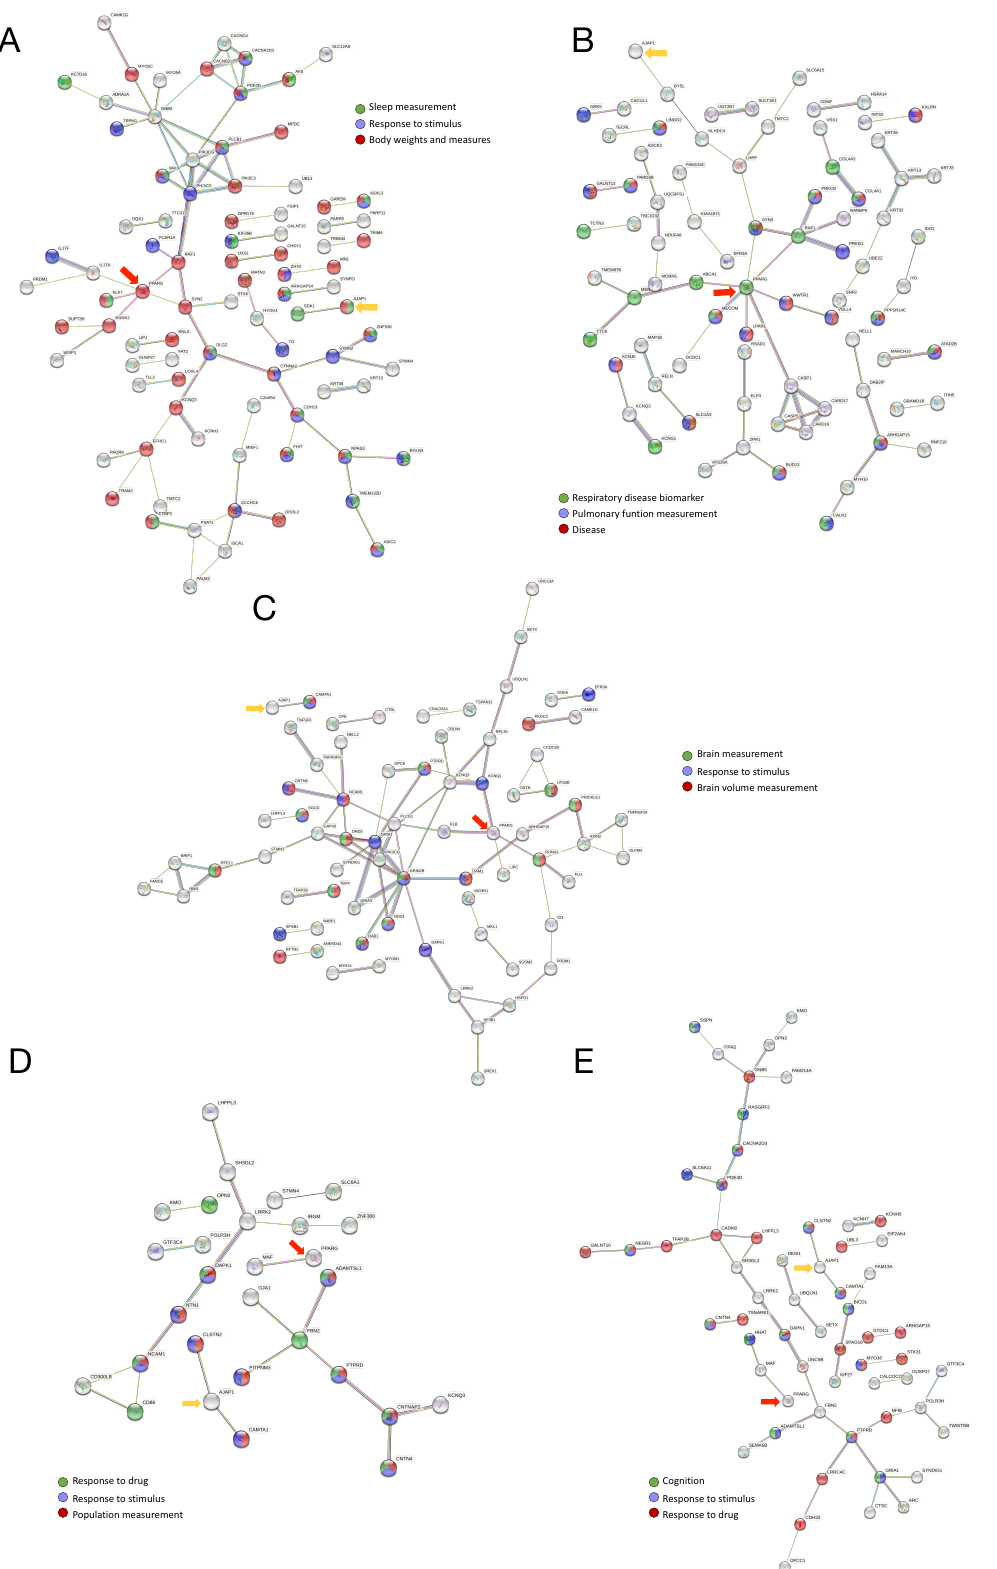
Figure 3. PPI networks constructed with significant adaptation signals observed in each region; PPARG and AJAP are highlighted with red and yellow arrows, respectively. ( A ) North. ( B ) Northwest. ( C ) Center. ( D ) South. ( E )